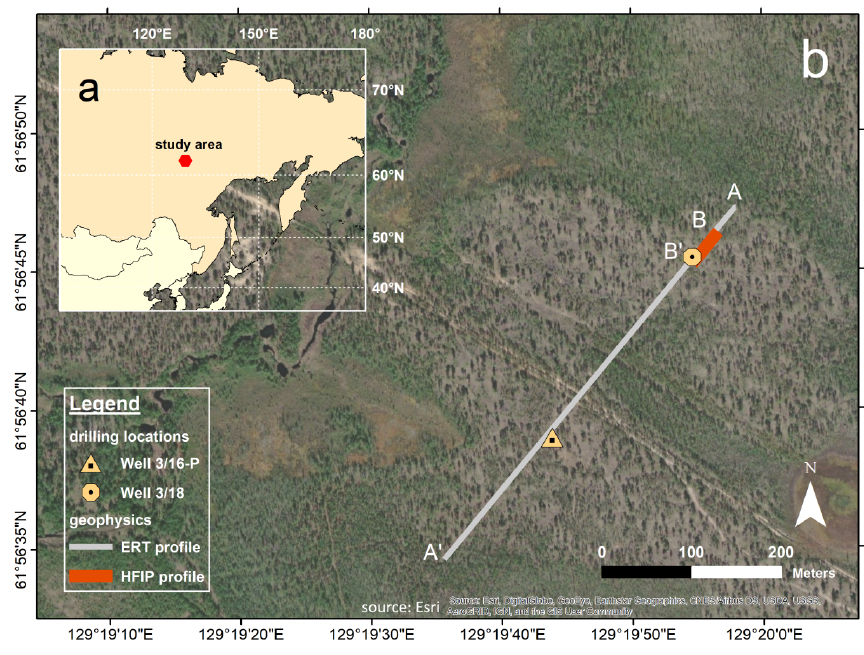
Figure 4. Geographical maps of the field site. Panel (a) gives an overview of the location of the study area in Russia. In Panel (b) the position of the ERT profile, directed from A to A (cid:48) , and the HFIP profile from B to B (cid:48) are shown, as well as the locations of boreholes 3/16-P and 3/18.